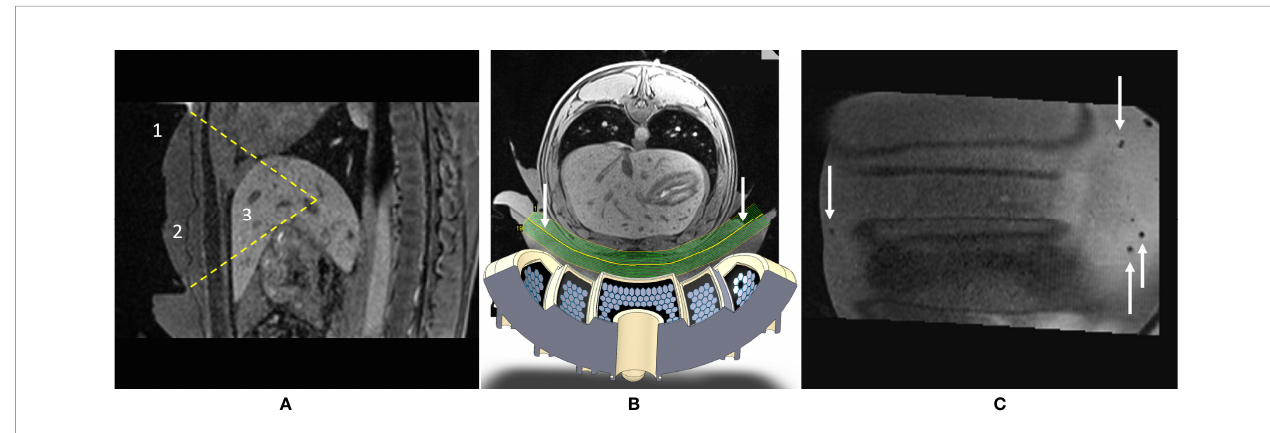
FIGURE 2 | (A) Sagittal T1w MR image illustrating the targeting in vivo. Visible are the 1) HIFU transducer with its natural focal depth, 2) coupling layer, and 3) liver. Field of view (FOV) = 150 mm × 205 mm. (B) Augmented reality axial view of the setup: shown are the numerical design of the transducer and the geometry of the curved slice reconstruction of the acoustic window (see arrows). (C) Curved reconstruction image of the membrane-to-skin contact surface, demonstrating the absence of trapped air bubbles in the active aperture. Small bubbles can be seen outside the beam pathway. FOV = 175 mm × 188